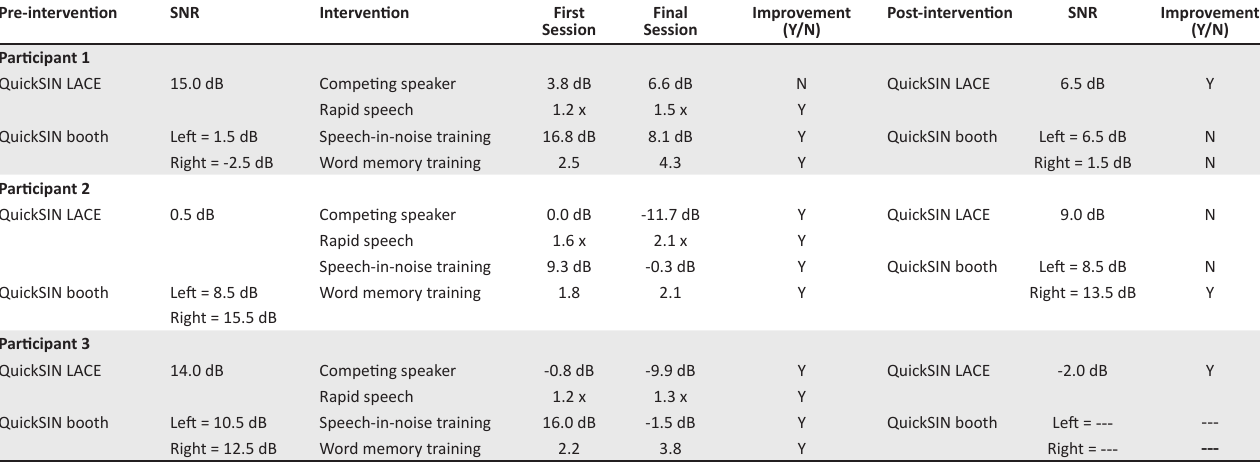
TABLE 3: Assessment and intervention results. Pre-intervention